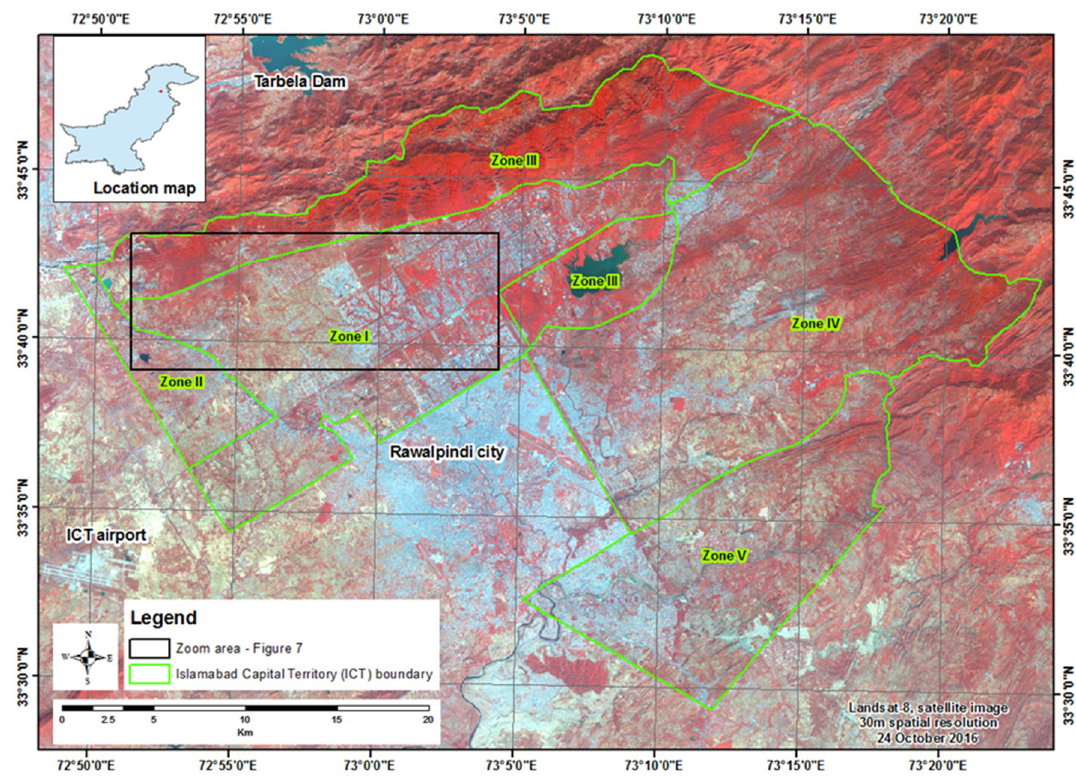
Figure 1. Study area map—Islamabad Capital Territory (ICT), Pakistan. The bounded box inset covering Zone I and Zone II partially is representing the area shown in the Figure in Section 5.